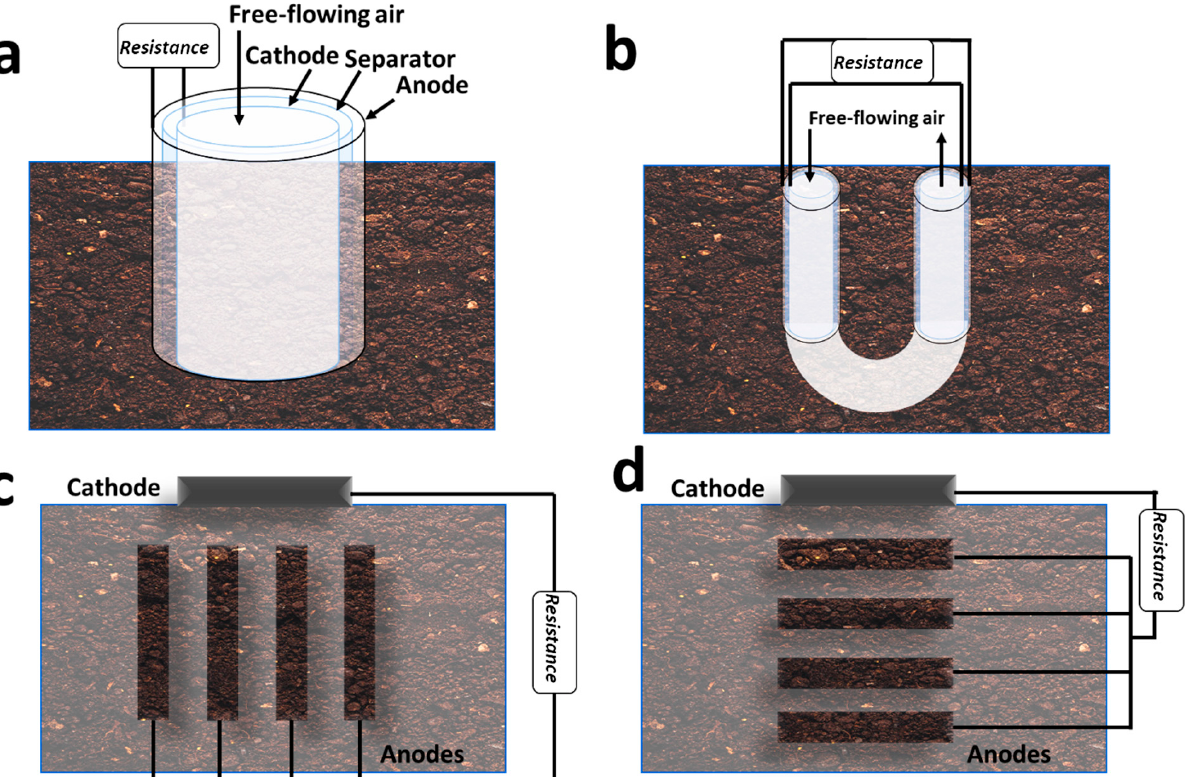
Figure 3. Different types of BES reactor designs developed for PH bioremediation: ( a ) snorkel-column-type; ( b ) U-type; ( c ) multiple anodes stacked vertically; ( d ) multiple anodes stacked horizontally.